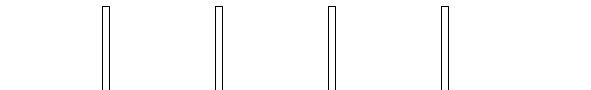
Figure 4. Pulse train used in the present DAS system (frequency = 1 to 100 kHz; pulse duration = 0.5